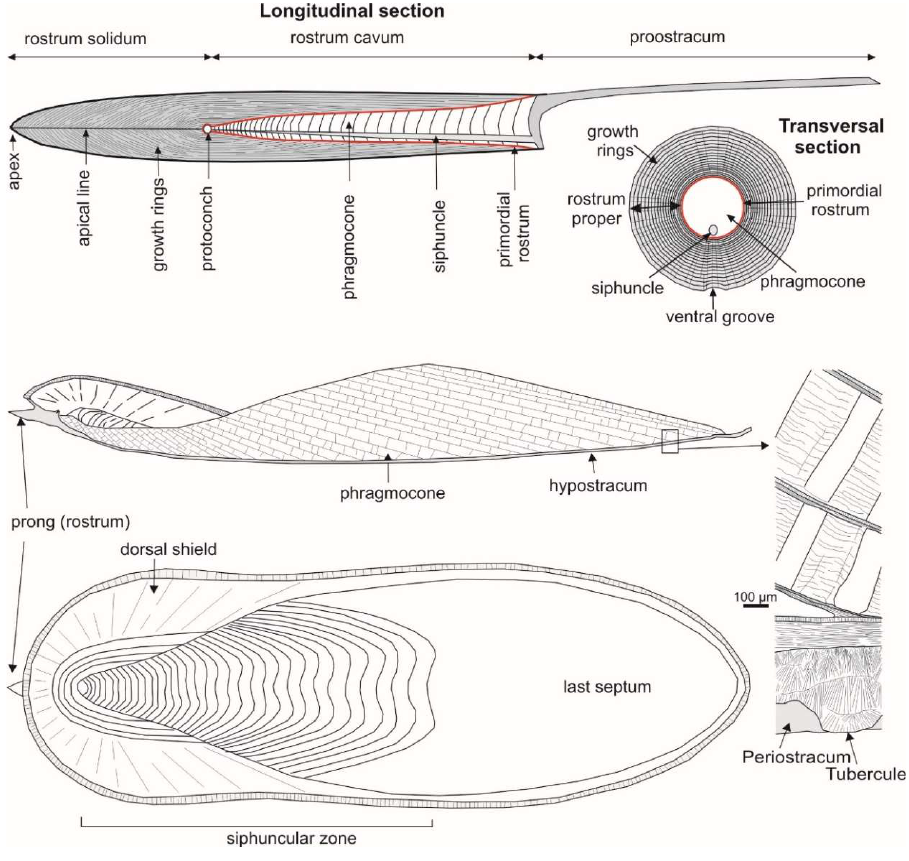
Figure 3. Sketch of the anatomy of the belemnite ( up ) and Sepia ( down ) endoskeleton. Red line indicates primordial rostrum.